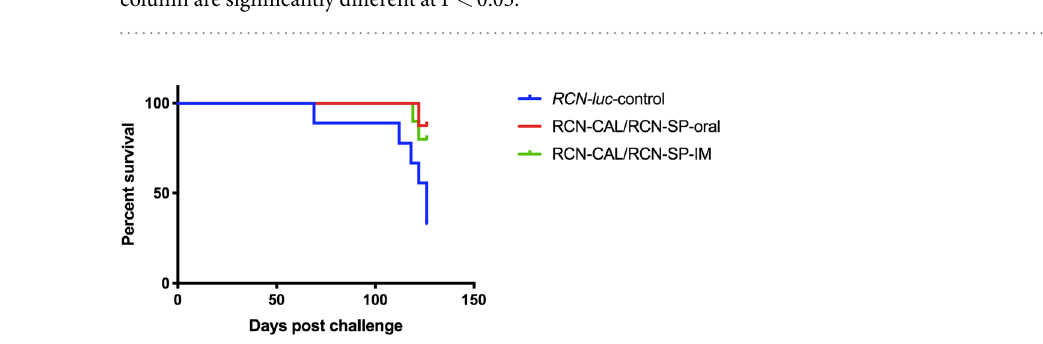
Table 2. Percent survival and mean weight (in grams) at challenge and at death or euthanasia in Myotis lucifugus vaccinated with raccoon poxvirus (RCN) expressing calnexin (RCN-CAL) and RCN expressing serine protease (RCN-SP) in combination, either via the oral route or intramuscular (IM) route, or RCN expressing luciferase (RCN- luc , control group). Bats were challenged with Pseudogymnoascus destructans three weeks after immunization and just prior to a 120 day hibernation period. Mean weights with different letters within a column are significantly different at P < 0.05.